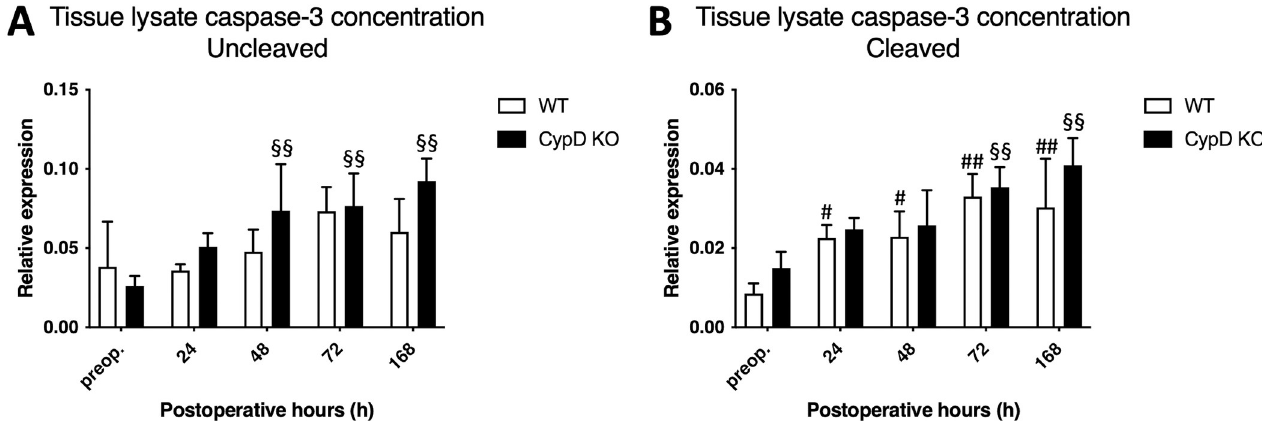
Fig 6. Expression of caspase-3. Uncleaved (A) and cleaved (B) caspase-3 total cell lysate protein concentrations preoperatively (preop., 0 h), and at 24 h, 48 h, 72 h, and 168 h after Associating Liver Partition and Portal vein ligation for Staged hepatectomy (ALPPS) (N = 6 per time point per group). � P < 0.050, �� P < 0.0010 versus wild type (WT); # P < 0.050, ## P < 0.001 WT versus corresponding controls (preop.); § P < 0.050, §§ P < 0.0010 CypD KO versus corresponding controls (preop.). Statistical analysis was performed with a two-way ANOVA and Tukey’s post hoc